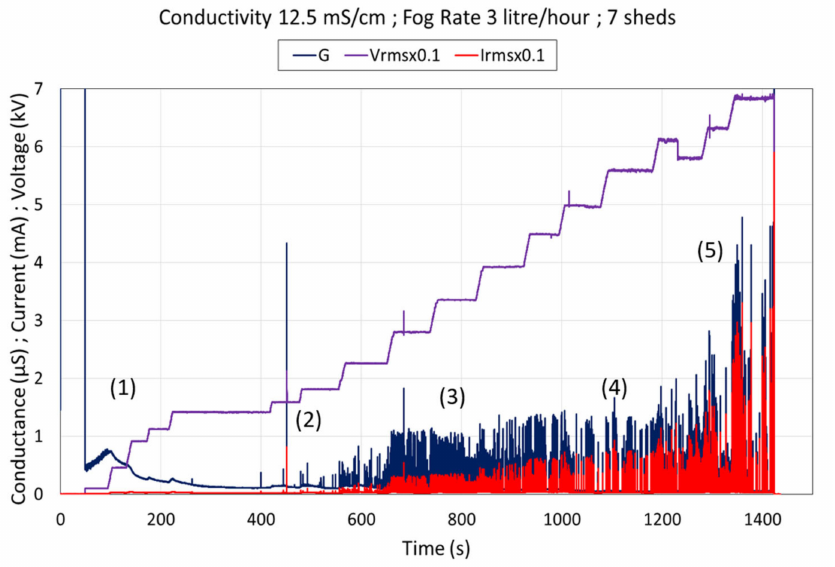
Figure 16. Surface conductance, leakage current, and applied free ramp voltage for severe pollution. Both voltage and current were divided by 10. (1), (2) (3), (4) and (5) are areas where LC activity and magnitude